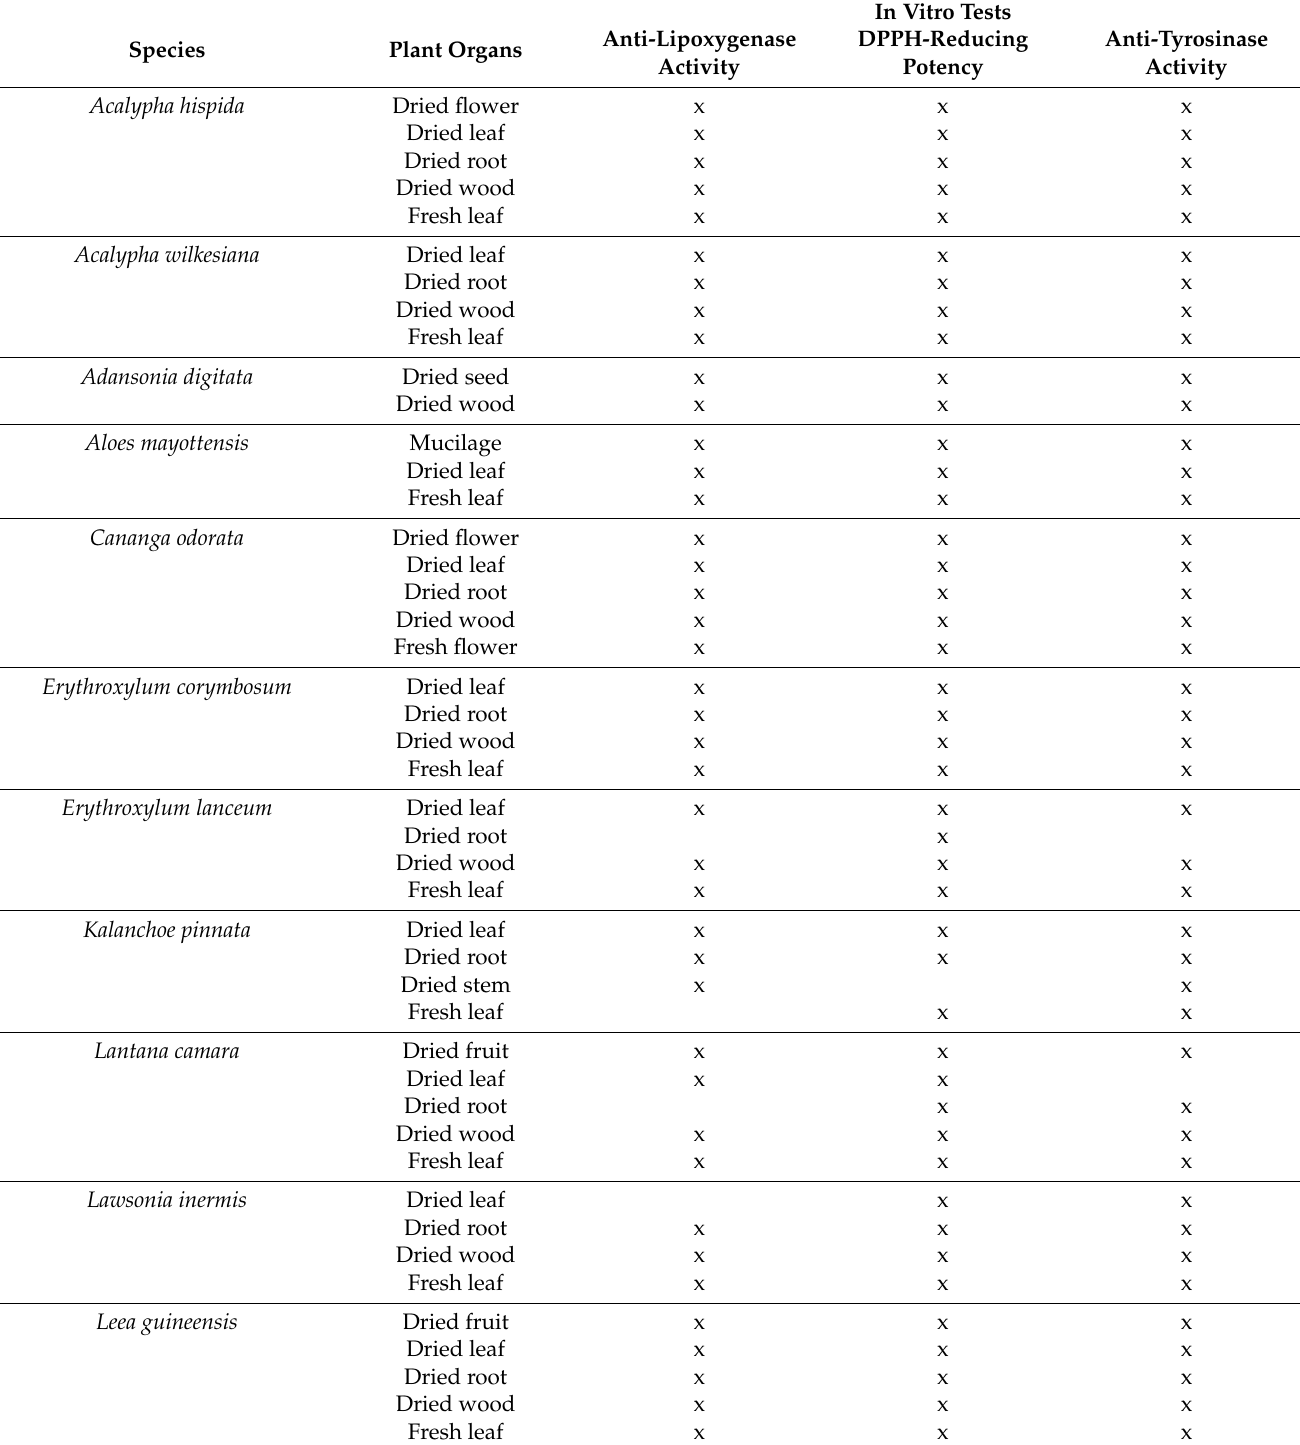
Table 1. Recapitulative table presenting the acetone extracts obtained from the different plant species and organs with the biological activities